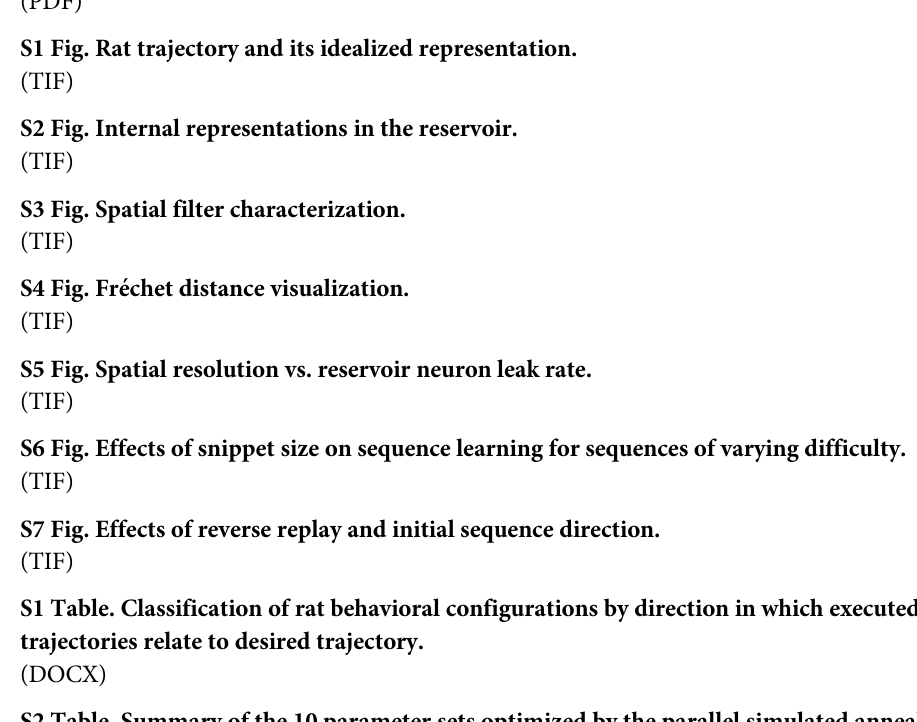
S1 Fig. Rat trajectory and its idealized representation. S2 Fig. Internal representations in the reservoir. S3 Fig. Spatial filter characterization. S4 Fig. Fre´chet distance visualization. S5 Fig. Spatial resolution vs. reservoir neuron leak rate. S6 Fig. Effects of snippet size on sequence learning for sequences of varying difficulty. S7 Fig. Effects of reverse replay and initial sequence direction. S1 Table. Classification of rat behavioral configurations by direction in which executed trajectories relate to desired trajectory. S2 Table. Summary of the 10 parameter sets optimized by the parallel simulated annealing algorithm. S3 Table. Performance (revealed by Fre´chet distance to desired trajectory) as a function